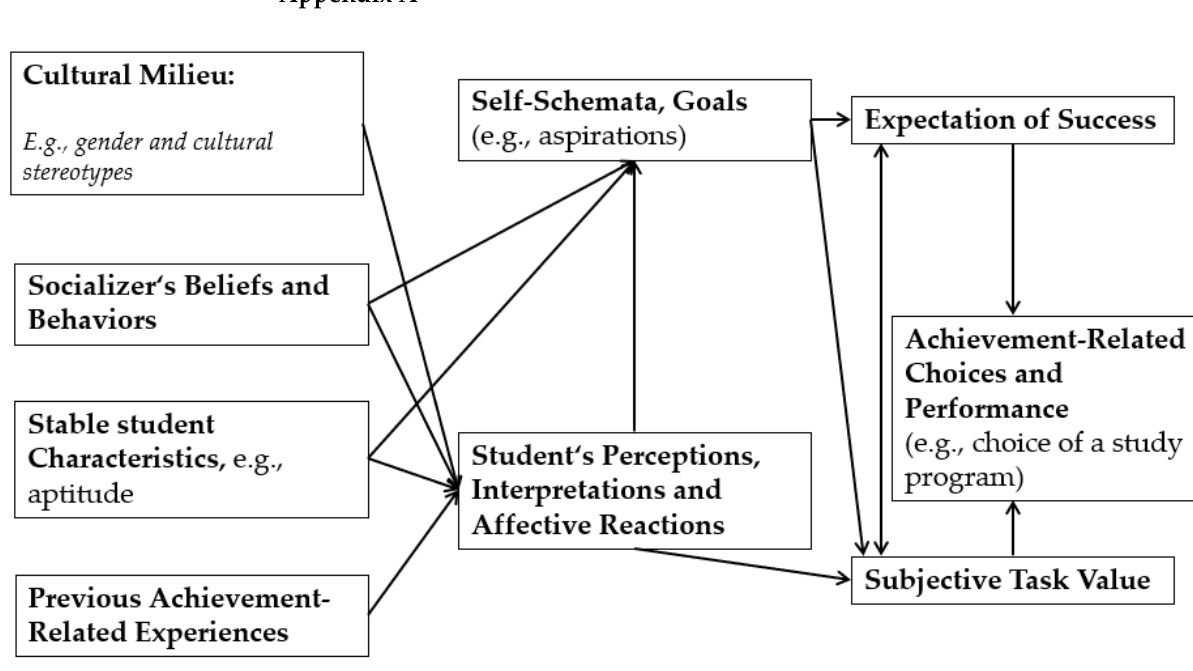
Figure A1. Simplified Expectancy–Value Model following Eccles and Wigfield (2002, p. 119).